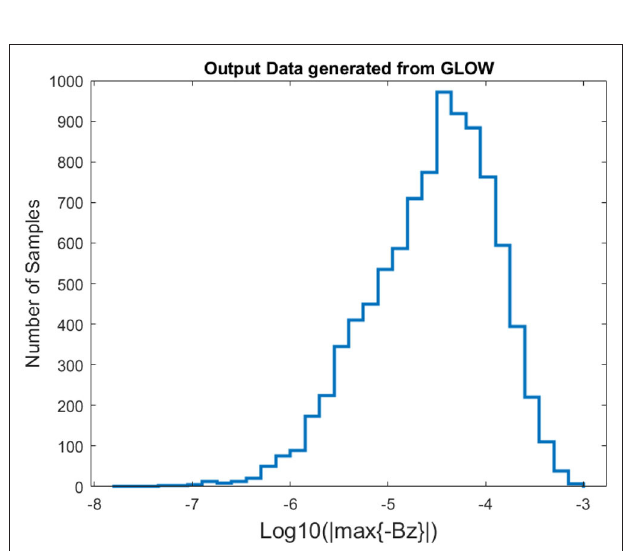
FIGURE 5 | Distribution of log10( | max {− B z }| ) values, where max {− B z } is in